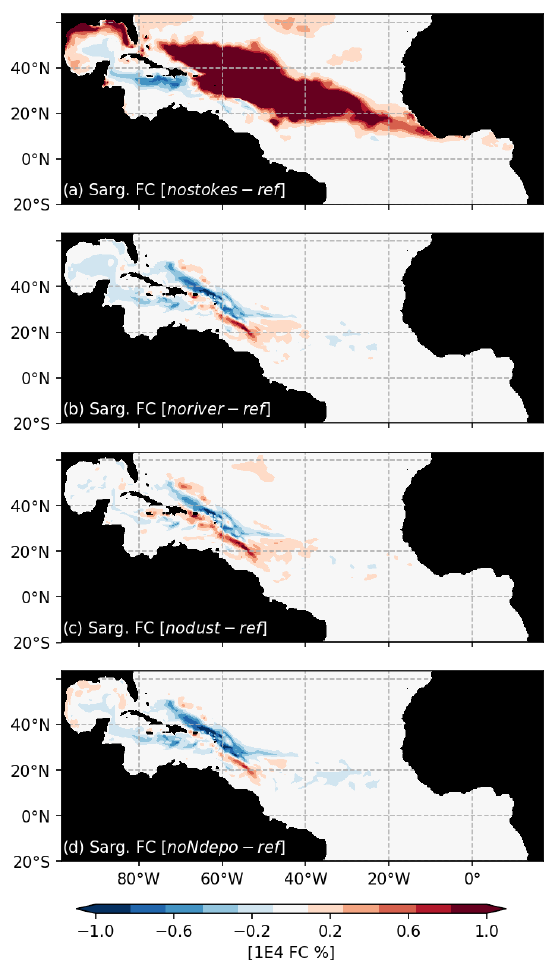
Figure 9. Ensemble anomalies of Sargassum coverage (in % of sur- face) from sensitivity ensemble simulations of 100 members each, which were performed with the set of parameters from (cid:127) 100